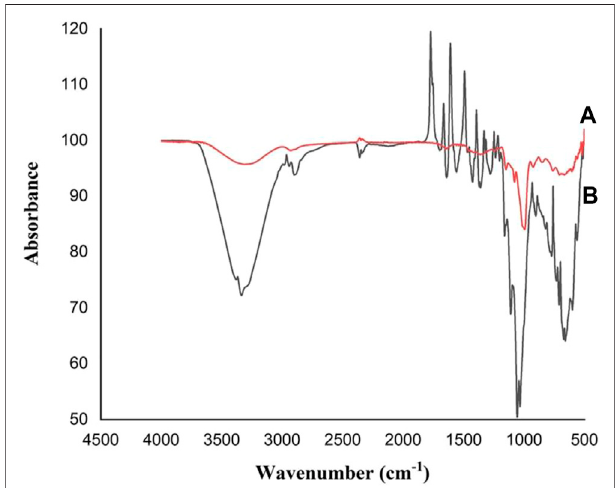
FIGURE 4 | FT – IR or Fourier transform infrared spectrums of L. acidophilus KLDS1.1003 free and MRS-based encapsulated with Pb (60 mg/ L): (A) Free L. acidophilus KLDS1.1003 biomass; and (B) MRS-based encapsulated L. acidophilus KLDS1.1003 biomass.